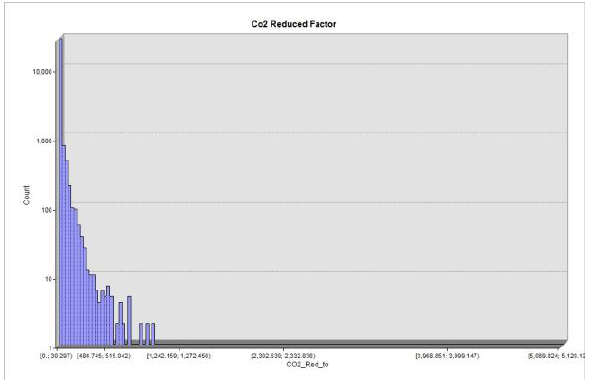
Figure 3 Data Histogram of CO2 Reduced values